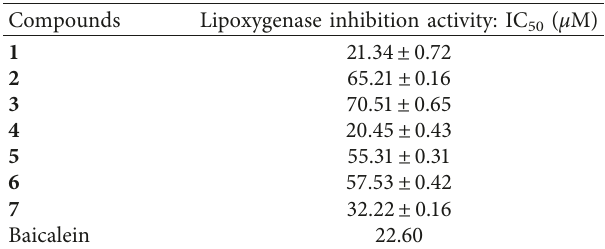
Table 3: Lipoxygenase inhibition activity of compounds 1 – 7 . Compounds